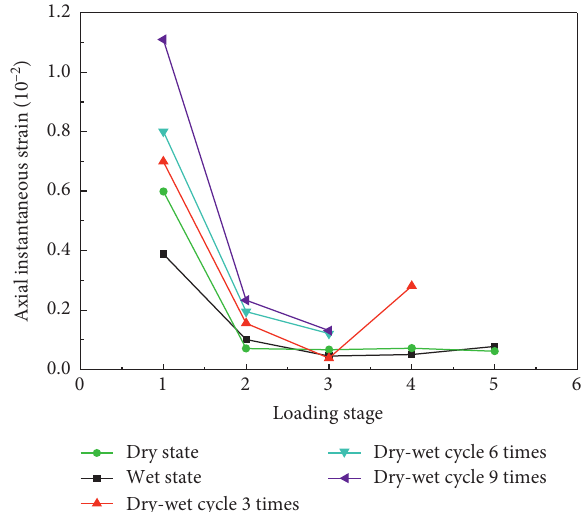
Figure 12: Instantaneous change of the strain in the specimens at each loading